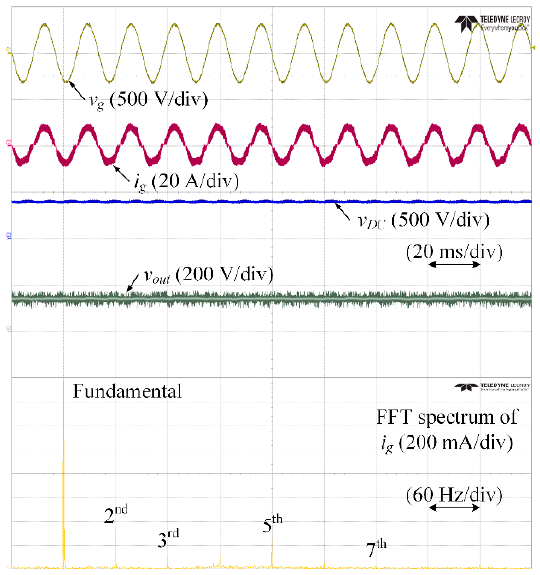
Figure 14. Experimental results of integrated OBC which performs battery charging.